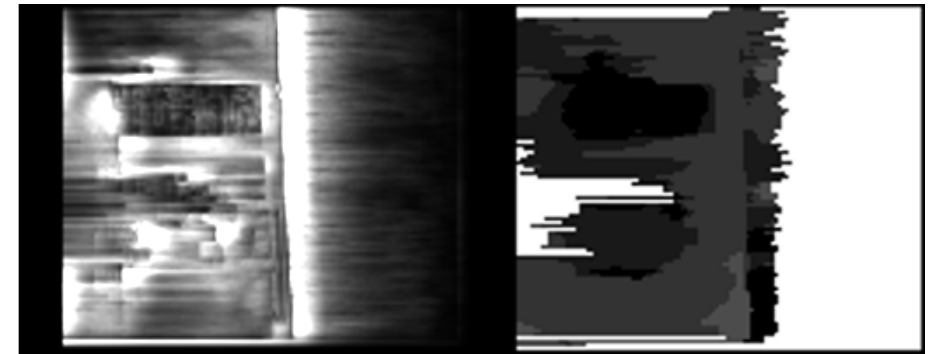
Figure 5. The certainty map from the image in Figure 4 is shown on the left. The right image shows which border pixels are discarded because of a low certainty (indicated as